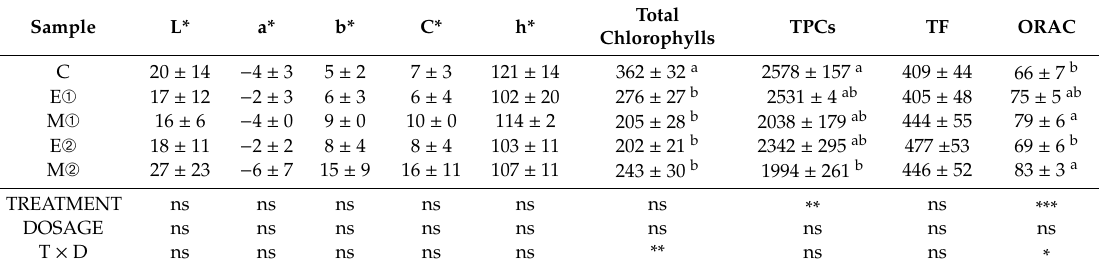
Table 2. Color parameters, chlorophyll content (mg / kg of f.w.), total phenolic compounds (TPCs) (mg GAE / kg f.w.), total flavonoids (TFs) (mg CE / kg f.w.), and oxygen radical absorbance capacity (ORAC) (mmol TE / kg f.w.) of broccoli samples in the dose of application assay for the five experimental